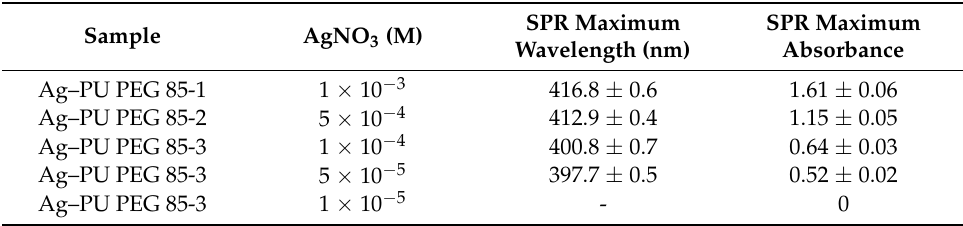
Figure 5. UV-Vis of spectra of Ag–PU PEG 85 hydrogel nanocomposite disks, while increasing the AgNO 3 concentration added to the PU hydrogel disk (Table 3). Inset: Pictures of the resulting Ag–PU hydrogel nanocomposite disks (error bars represent standard deviation for studies conducted in triplicate).